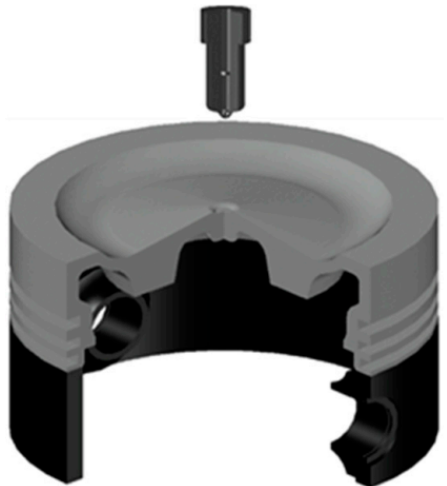
Figure 2. The quarter-cut 3D geometries of the piston and the pilot fuel